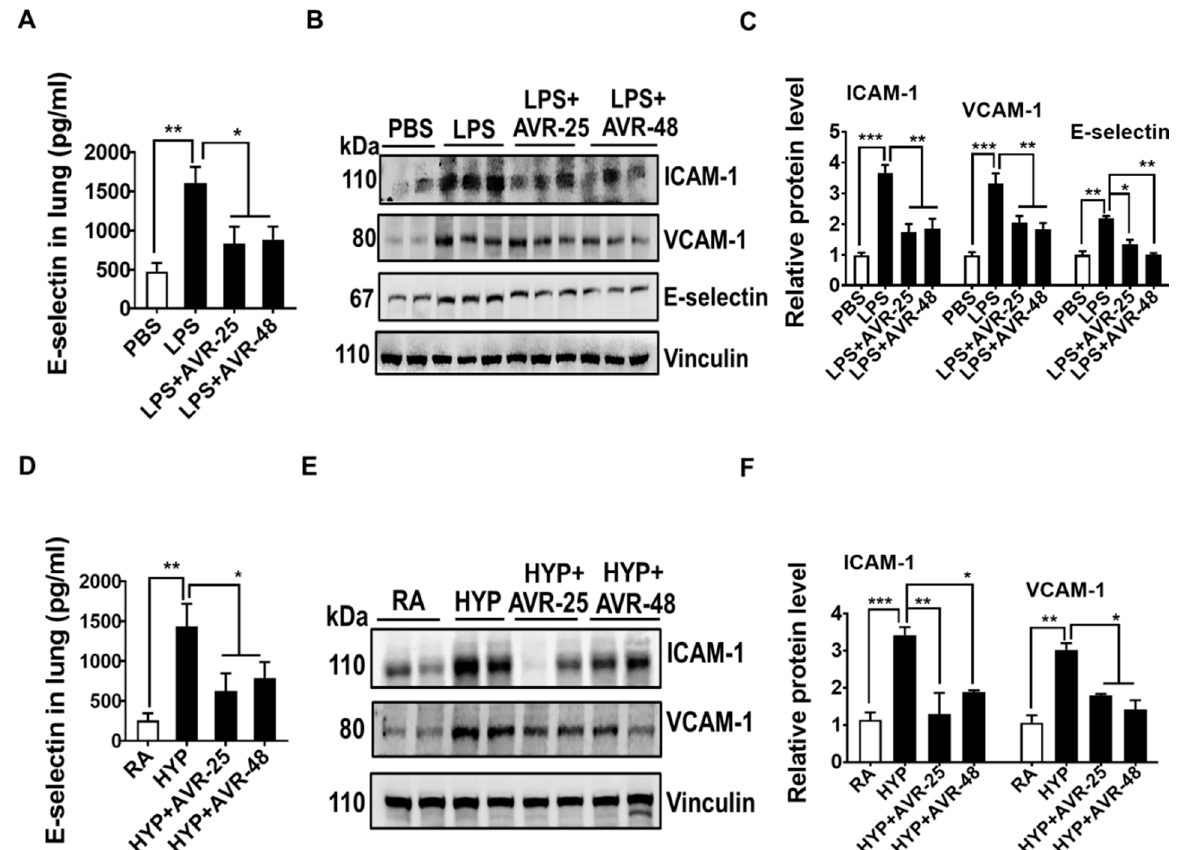
Figure 3. AVR-25 or AVR-48 treatment suppresses the production of lung adhesion molecules in in LPS- and hyperoxia- induced ALI mice. ( A , D ) ELISA assay for the levels of E-selectin in lungs of LPS- and hyperoxia-induced ALI in mice treated with or without AVR-25 or AVR-48 ( n = 5–6, * p < 0.05 and ** p < 0.01). ( B , C , E , F ) Western Blots analysis for ICAM-1, VCAM-1, and E-selectin in the lungs of LPS- and hyperoxia-induced ALI in mice treated with or without AVR-25 or AVR-48. Right panel shows densitometric quantification of the immunoblots ( n = 4–6, * p < 0.05, ** p < 0.01 and *** p < 0.001). Data are expressed as mean ± SEM. For statistical analysis, student’s unpaired t -test and one-way analysis of variance (ANOVA) followed by Tukey post hoc analysis were used. LPS: lipopolysaccharide; ALI: acute lung injury; PBS: phosphate